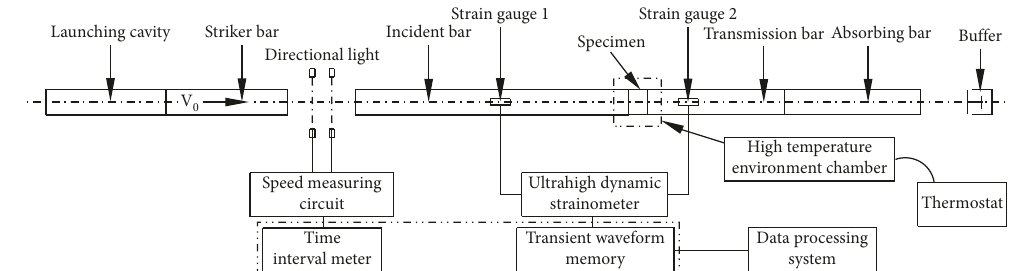
Figure 2: Sketch of the SHPB experimental device.